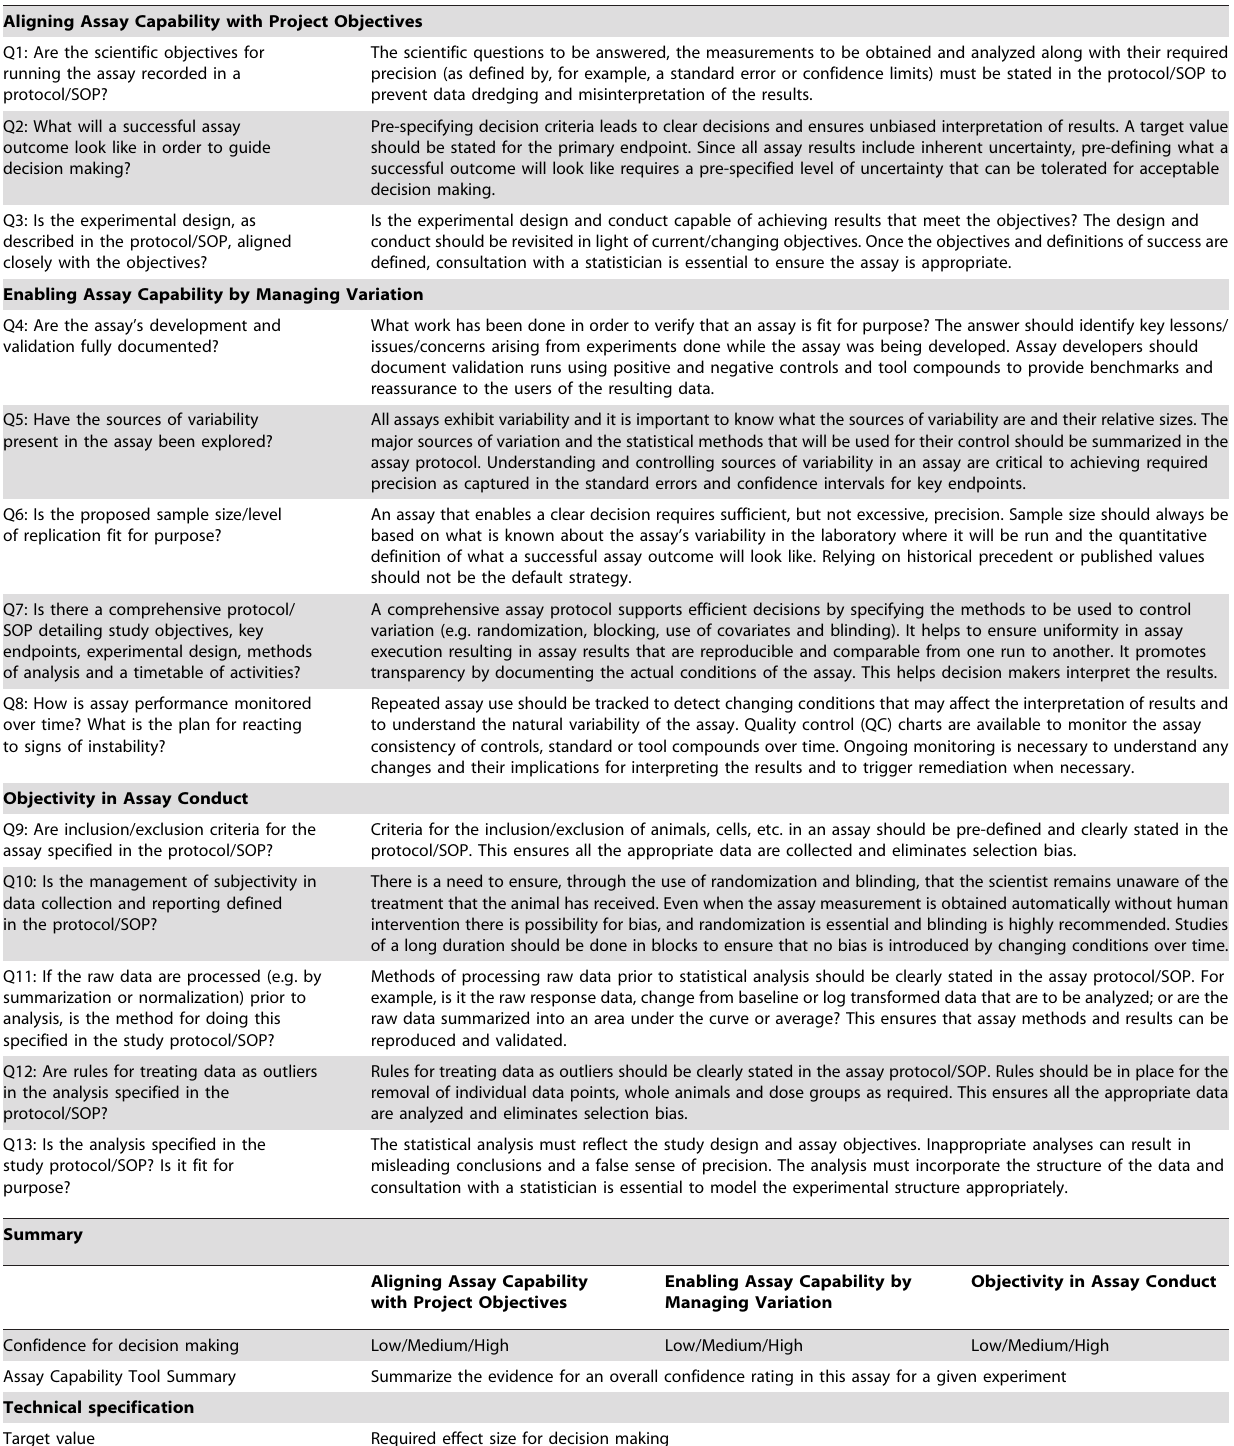
Table 1. Assay Capability